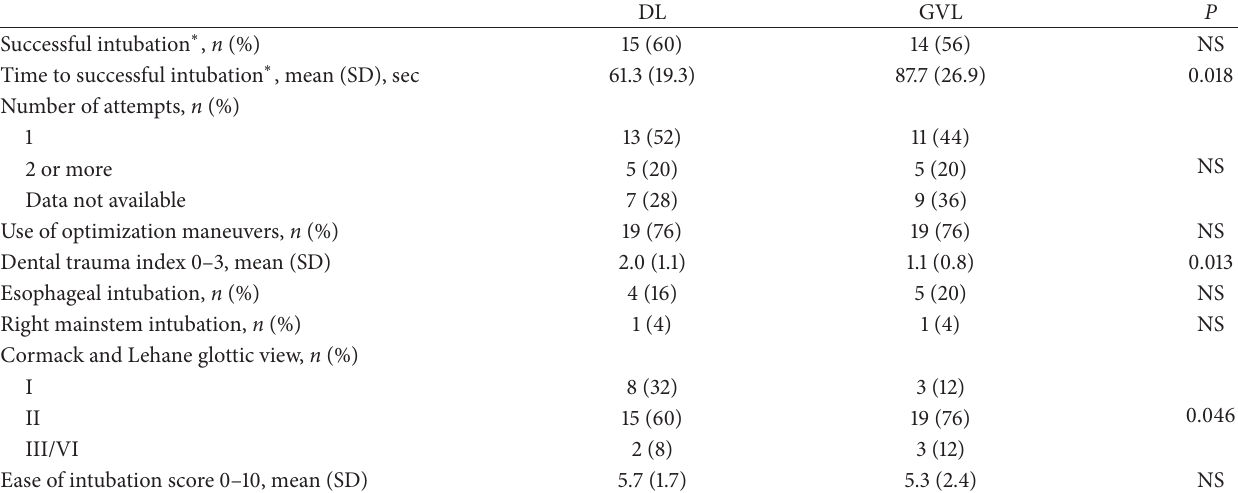
Table 3: Results for the difficult airway scenario ( 𝑁 = 25